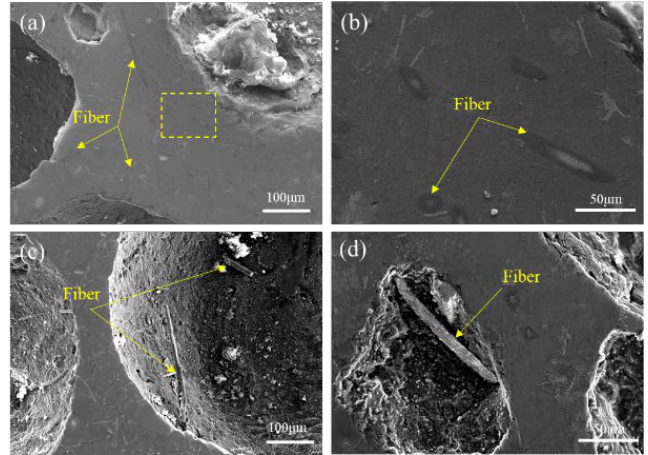
Figure 7. Distribution of BF in the composite foam: ( a ) Entirely embedded in the cell wall; ( b ) enlarged image of BF from ( a ); ( c ) partially protruding from the cell wall; ( d ) penetrating through the cell.